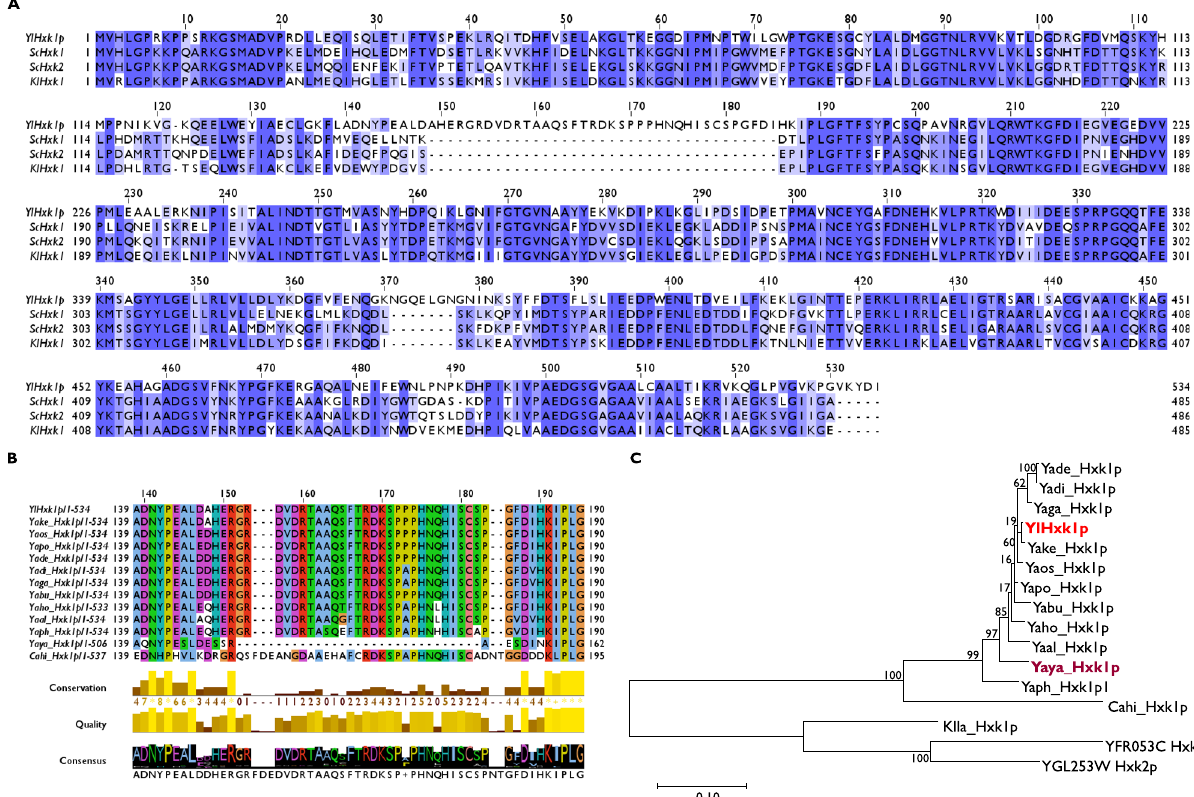
Figure 1. ( A ) Sequence alignment of YlHxk1, ScHxk1, ScHxk2 and KlHxk1; ( B ) sequence alignment of the loop region of hexokinases in the Yarrowia clade; ( C ) phylogenetic tree of the hexokinases based on Maximum likelihood. Bootstrap values are shown next to the branches. The tree is drawn to scale, with branch lengths representing the number of substitutions per